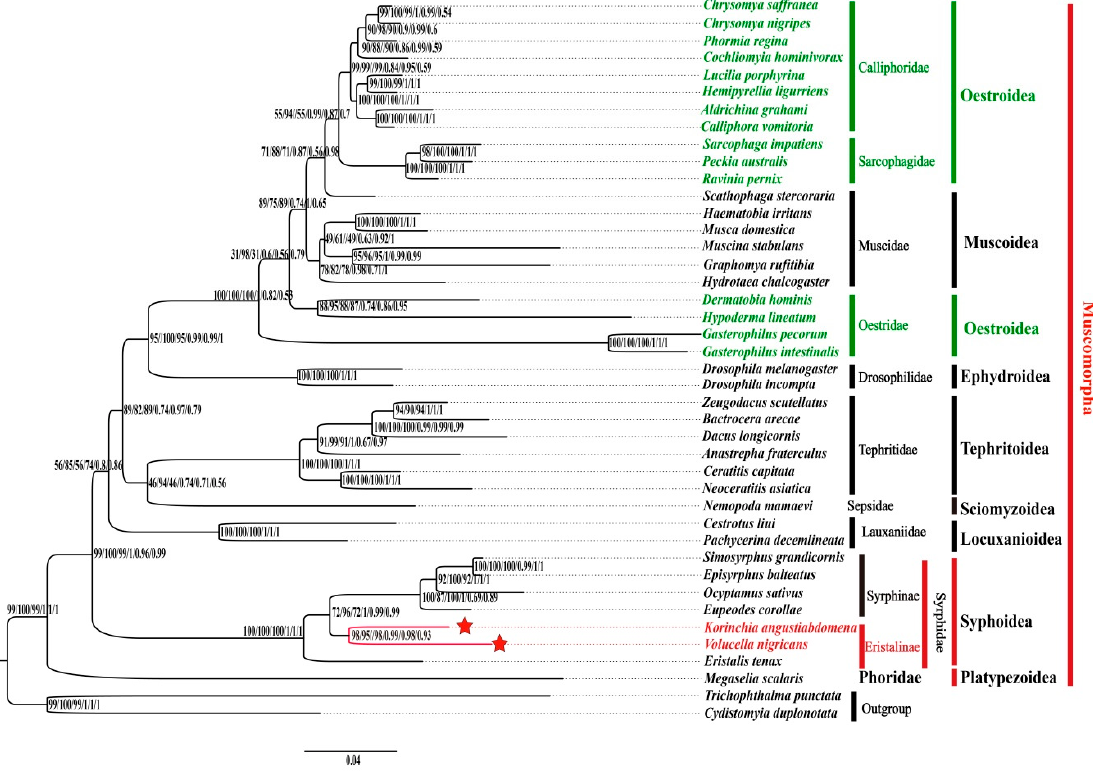
Figure 6. Phylogenetic relationships for Syrphidae based on the AA / PCG12RNA / PCGRNA datasets inferred from iq-tree and PhyloBayes. Numbers on branches are Bootstrap values and Bayesian posterior probabilities (PP) (ML-AA; ML-PCG12RNA; ML-PCGRNA; PB-AA; PB-PCG12RNA and PB-PCGRNA, respectively).